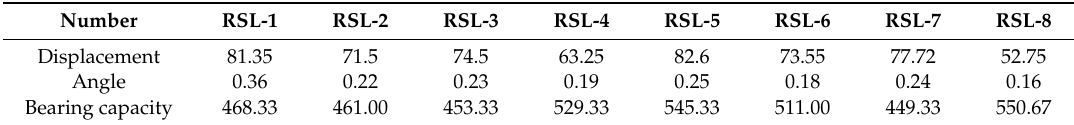
Table 8. Maximum response